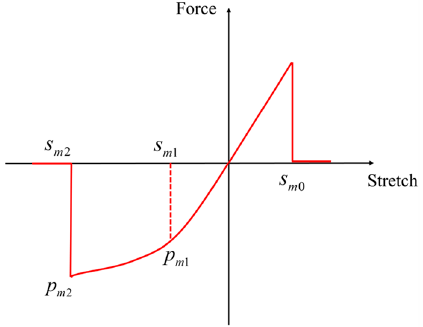
Figure 6. PD constitutive relation of the matrix bond.